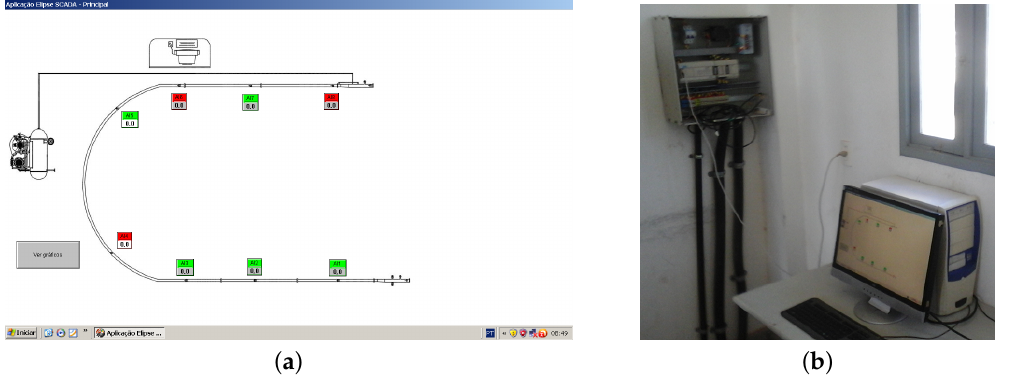
Figure 4. Workstation of supervisory system. ( a ) print screen of supervisory; ( b ) PLC box and desktop computer. Source: By